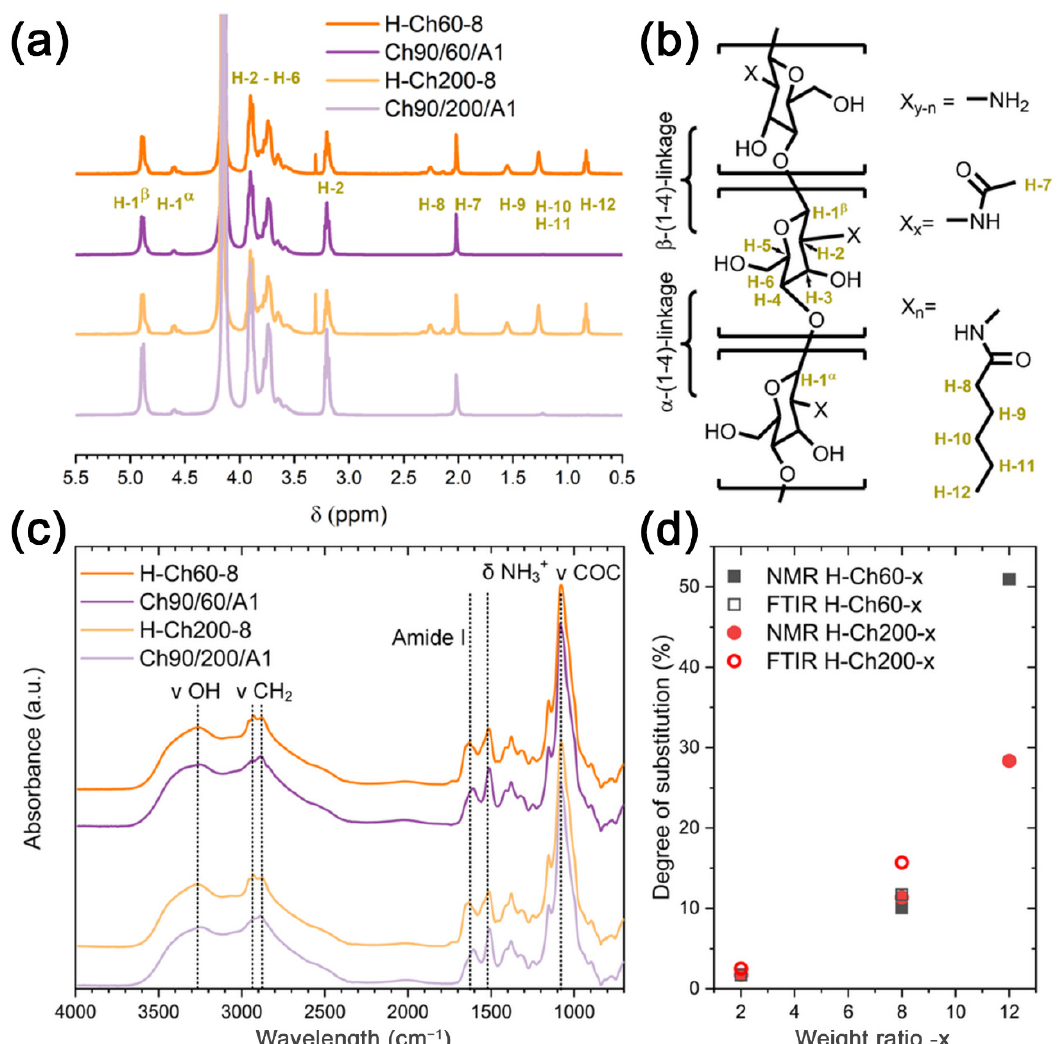
Figure 1. ( a ) 1 H-NMR spectra of Ch90/60/A1 (dark purple), H-Ch60-8 (orange), Ch90/200/A1 (light purple), and H-Ch200-8 (yellow) with peak assignments, and ( b ) the structure with proton-to-peak assignment (all of the spectra in Figures S1 and S2). ( c ) ATR-FTIR spectra of H-Ch60-8 (orange) compared to Ch90/60/A1 (dark purple), and H-Ch200-8 (yellow) compared to Ch90/200/A1 (light purple), with band assignments at 3600–3100 cm − 1 ( ν (OH)), 2918 cm − 1 and 2879 cm − 1 ( ν (CH 2 )), 1653 cm − 1 (Amide I, increases with N-acylation), 1510 cm − 1 ( δ (NH 3+ )), and 1080 cm − 1 (polysaccharide, ν C-O-C and ν C-OH) (all of the spectra in Figures S3 and S4). ( d ) Comparison of the degree of substitution in the dependency of the applied weight ratio of hexanoyl chloride to chitosan (x). H-Ch60-12 and H-Ch200-12 were not measured due to solubility issues.